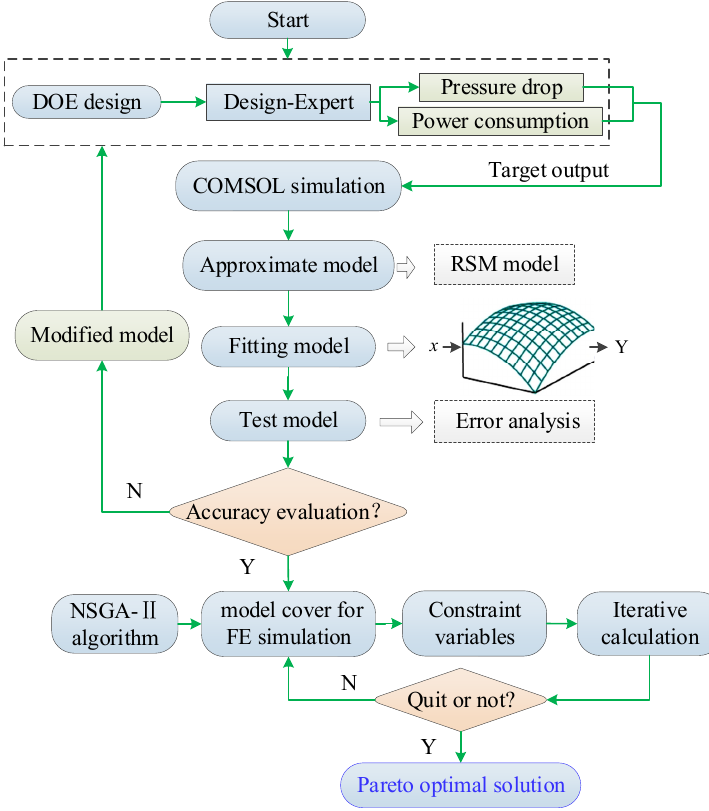
Figure 6. Multi-objective optimization design process.